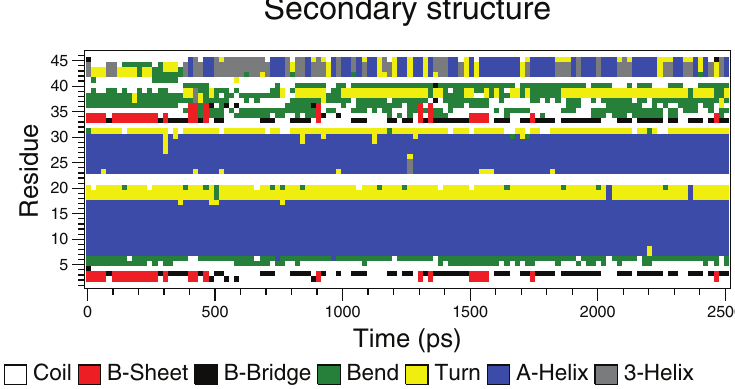
Figure 1. An Example DSSP Secondary Structure Plot (from 520K run 1).